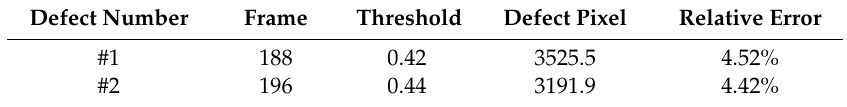
Table 4. Statistics of defect parameters using the maximum temperature difference method.